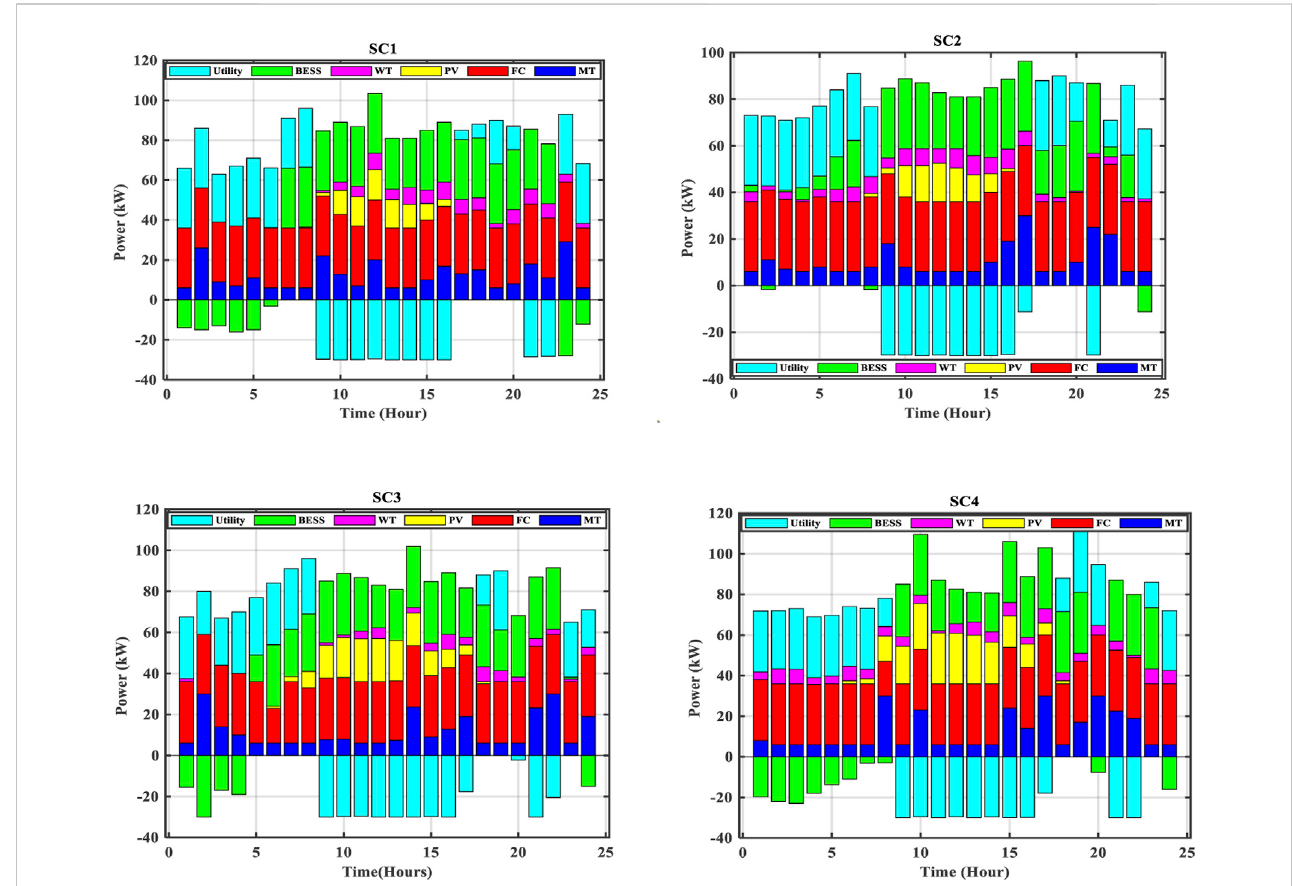
FIGURE 9 Case 4 with 15% DSM, SC1, SC2, SC3,